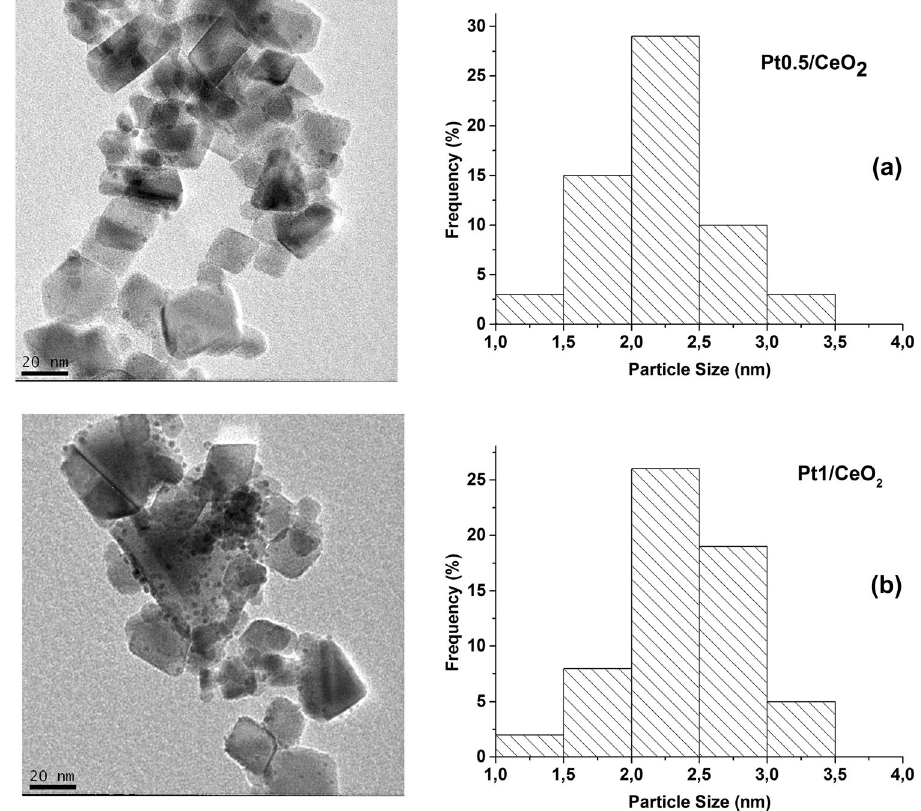
Fig. 2 Transmission electron micrographs and histograms of ( a ) Pt0.5/CeO 2 and ( b ) Pt1/ CeO